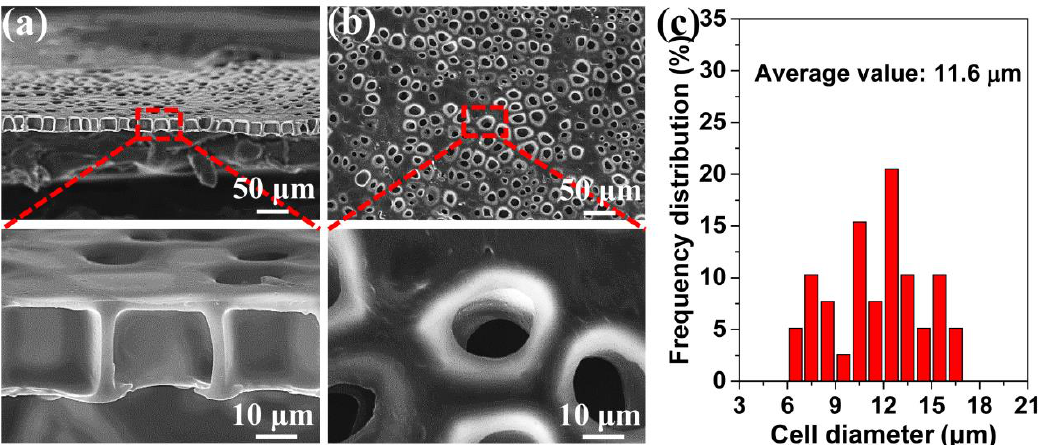
Figure 3. The TPU perforated membrane saturated under 2.0 MPa and foamed at 120 ◦ C. ( a ) the cross-section, ( b ) the surface, ( c ) the average diameter of the cells on the surface.